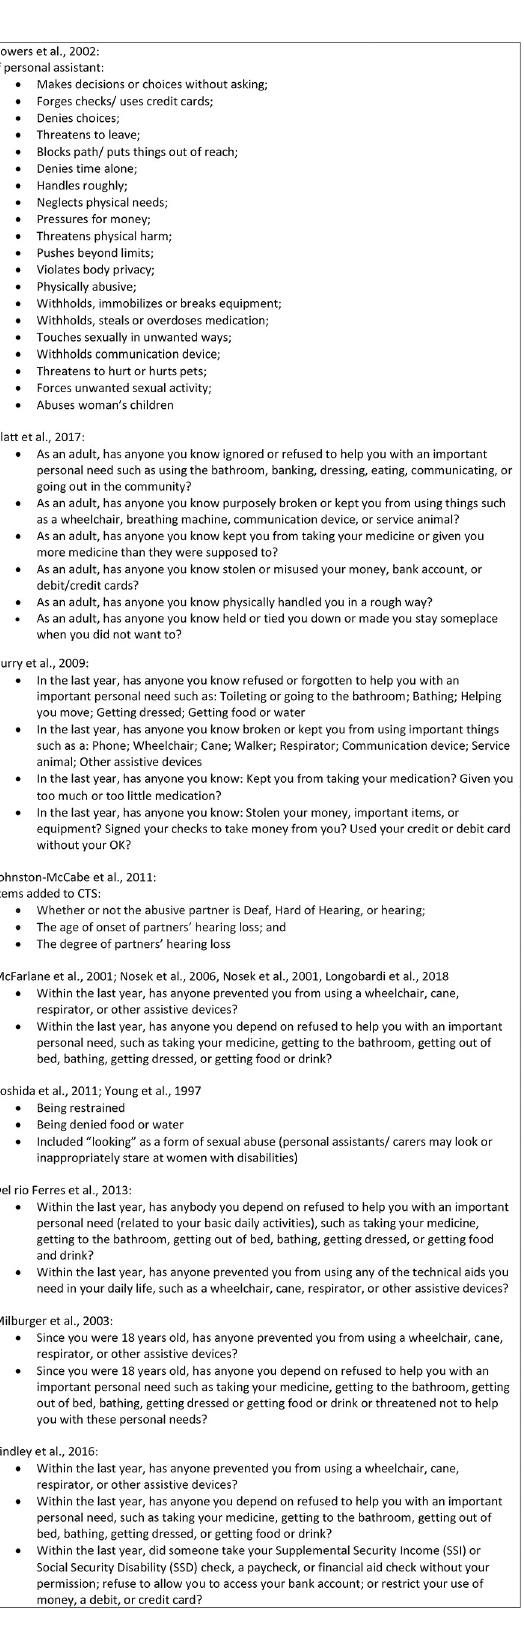
Fig 2. Disability-specific